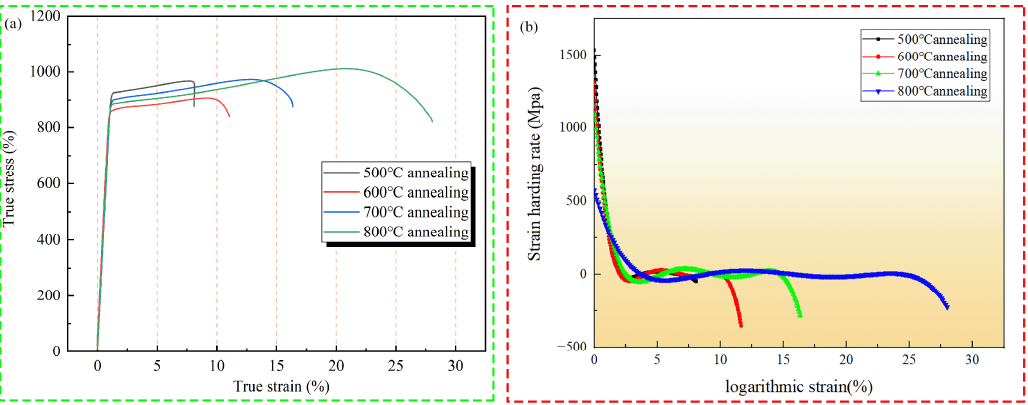
Figure 4. Stress-strain curve diagram and strain hardening diagram of Ti-20Zr-15Mo alloy after annealing: ( a ) true stress-strain curves; ( b ) strain hardening diagram. Table 1. Yield strength, compressive strength and elongation after fracture of the annealed Ti-20Zr-15Mo alloys.